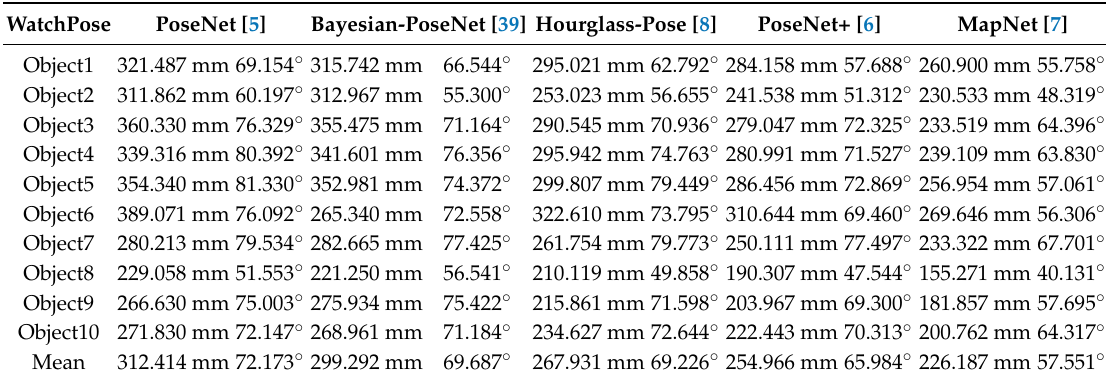
Table 7. Estimated camera location (mm) and orientation ( ◦ ) errors of different pose regression approaches using the augmented Industrial10-Traditional